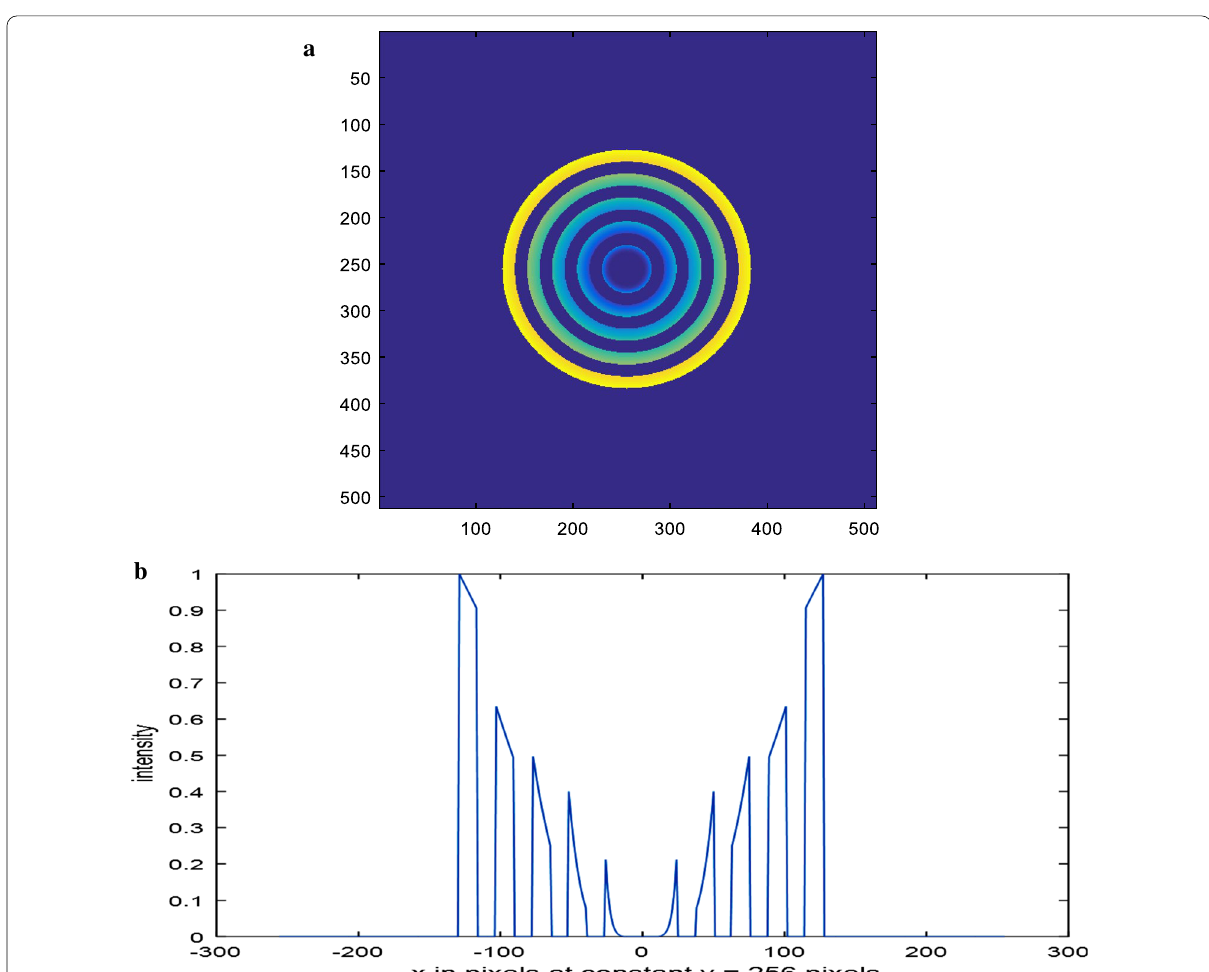
Fig. 7 a Color image corresponding to the second model of polynomial aperture showing ten concentric layers of B/W polynomial distribution where the center is dark. The layers from the center are 0, ρ 8 , 0, ρ 6 , 0, ρ 2 , 0, ρ . b The intensity plot of the second model of polynomial aperture shown in the ( a ) at the center of the aperture at constant y 256 =